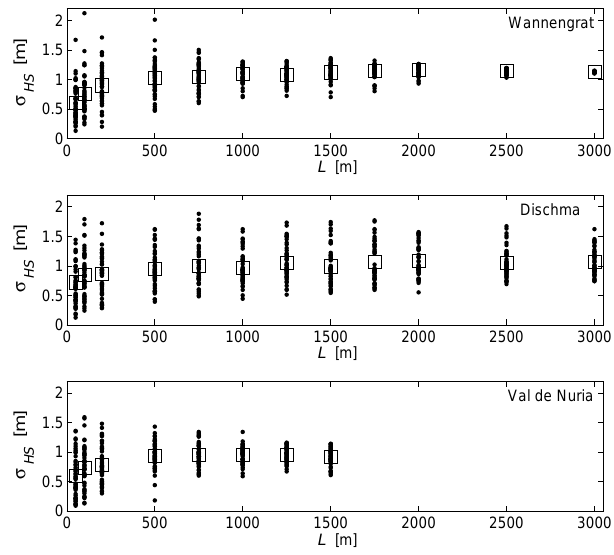
Figure 5. Standard deviation of snow depth σ HS as function of do- main size L for all three areas. The squares represent mean σ HS